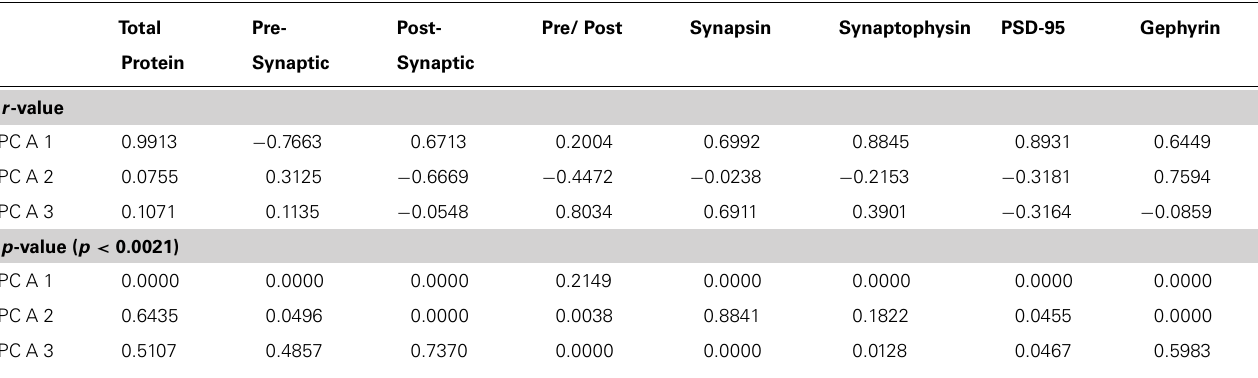
Table 2 | principal component analysis